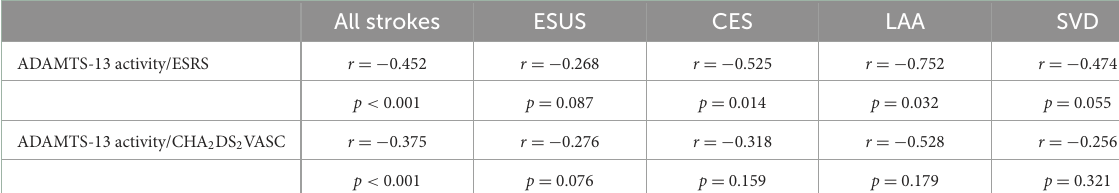
TABLE 3 Correlation of ADAMTS-13 activity with vascular risk scores in cohort 1, stratified by stroke etiology. All strokes ESUS CES LAA SVD ADAMTS-13 activity/ESRS r = − 0.452 r = − 0.268 r = − 0.525 r = − 0.752 r = − 0.474 p < 0.001 p = 0.087 p = 0.014 p = 0.032 p = 0.055